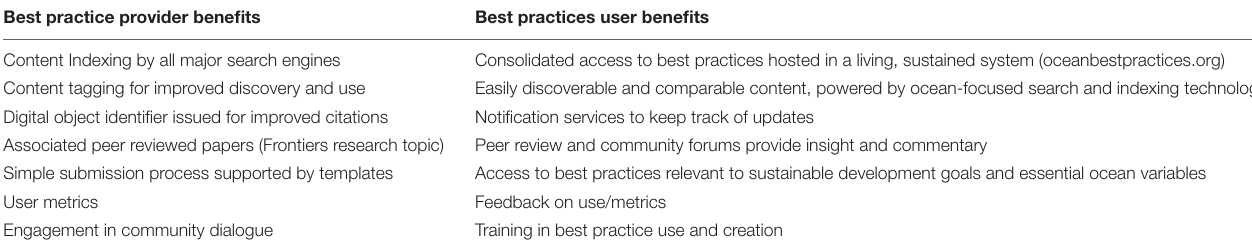
TABLE 2 | Ocean best practices provider and user benefits. Best practice provider benefits Best practices user